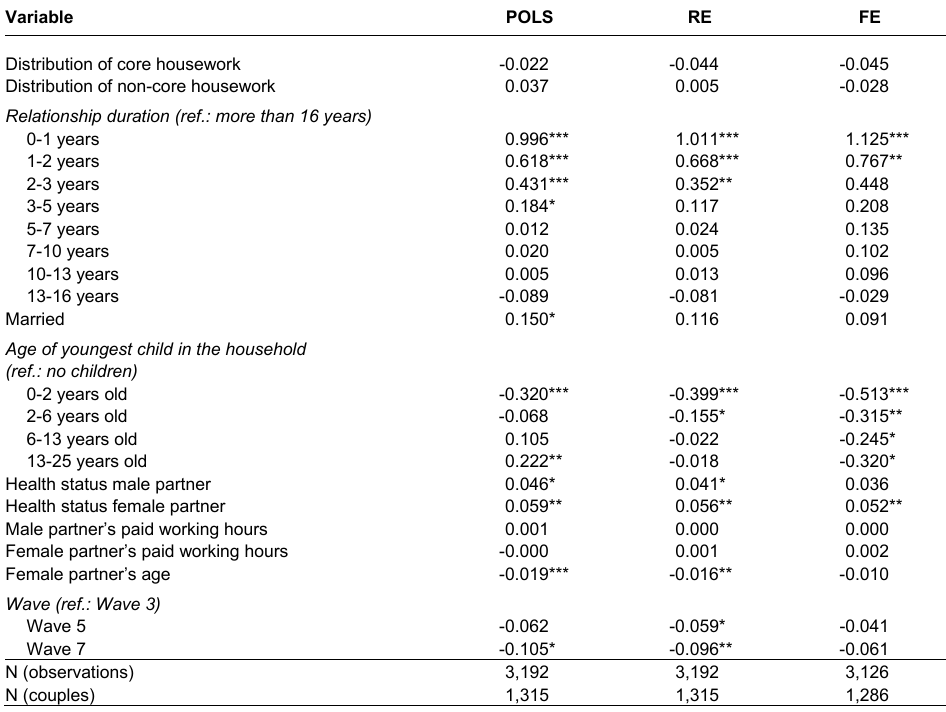
Table A.1 : Summary of pooled OLS (POLS), random (RE), and fixed effects